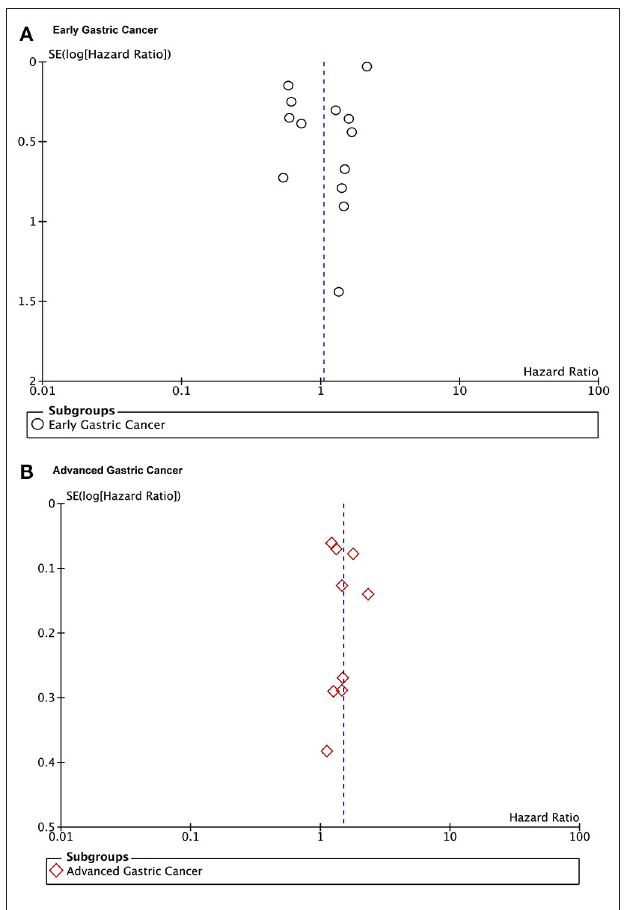
FIGURE 5 | Funnel plots of the overall survival outcomes. (A) Early gastric cancers. (B) Advanced gastric cancers.